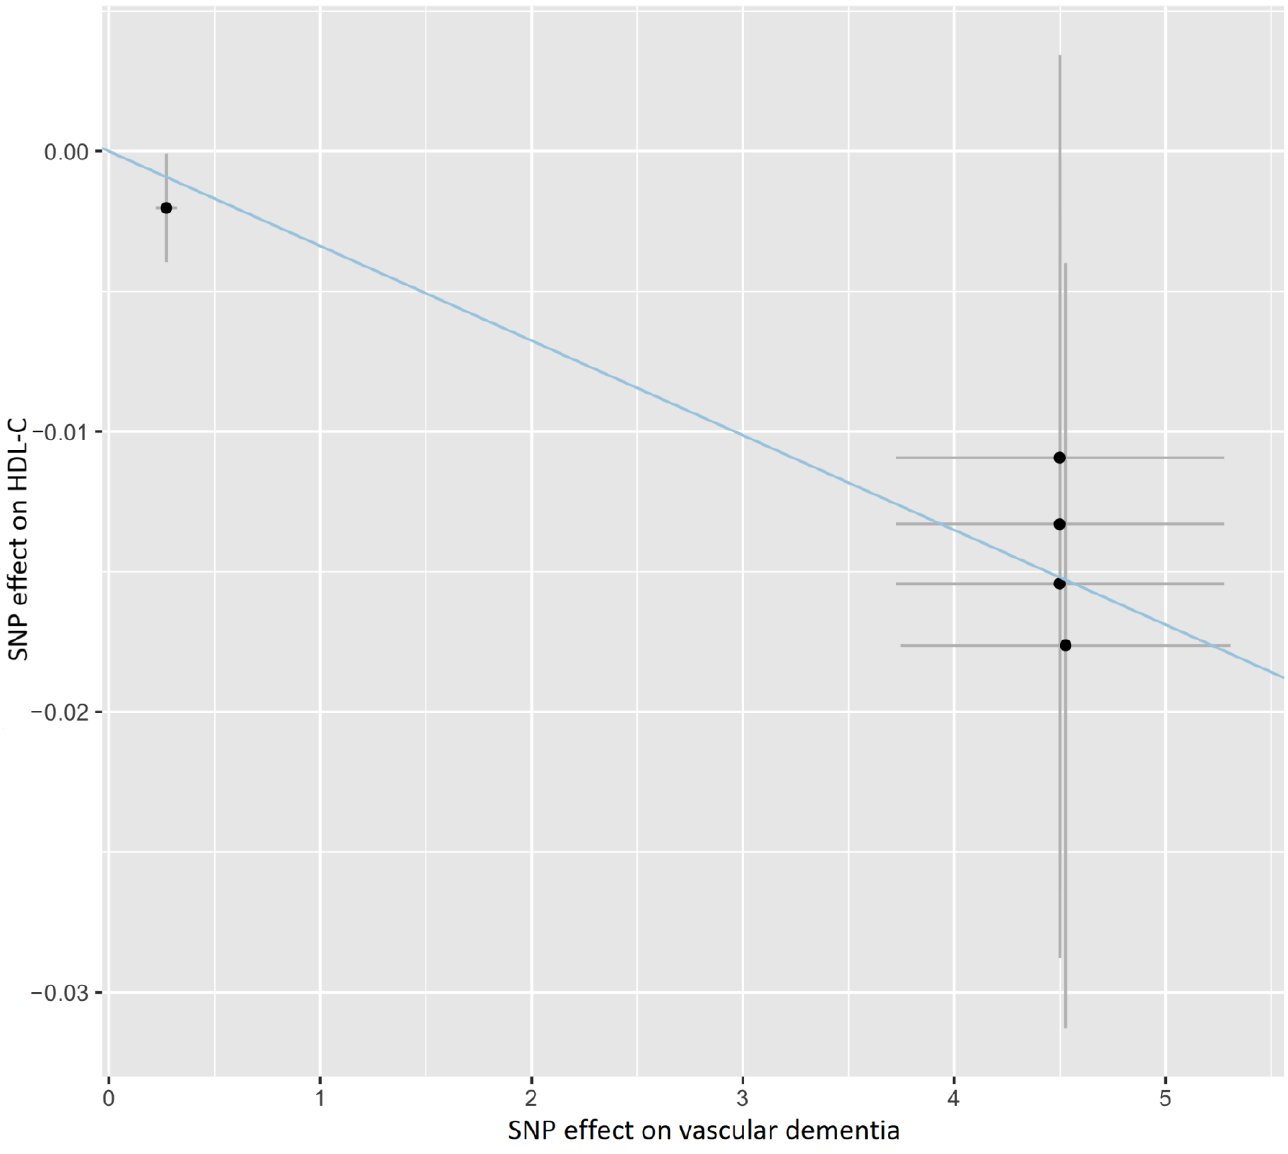
Figure 2. Scatter plot showing the association of the SNP effects on VaD against the SNP effects on the HDL-C level. The blue line indicates the estimate of the effect using the IVW method. Circles indicate marginal genetic associations with VaD and risk of HDL-C level for each variant. Error bars indicate 95% CIs. IVW: inverse-variance weighted; VaD: vascular dementia; HDL-C: high-density lipoprotein cholesterol; SNP: single nucleotide polymorphism.